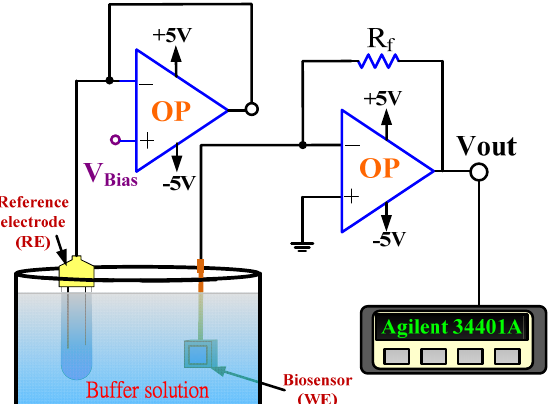
Figure 2. The amperometry measurement